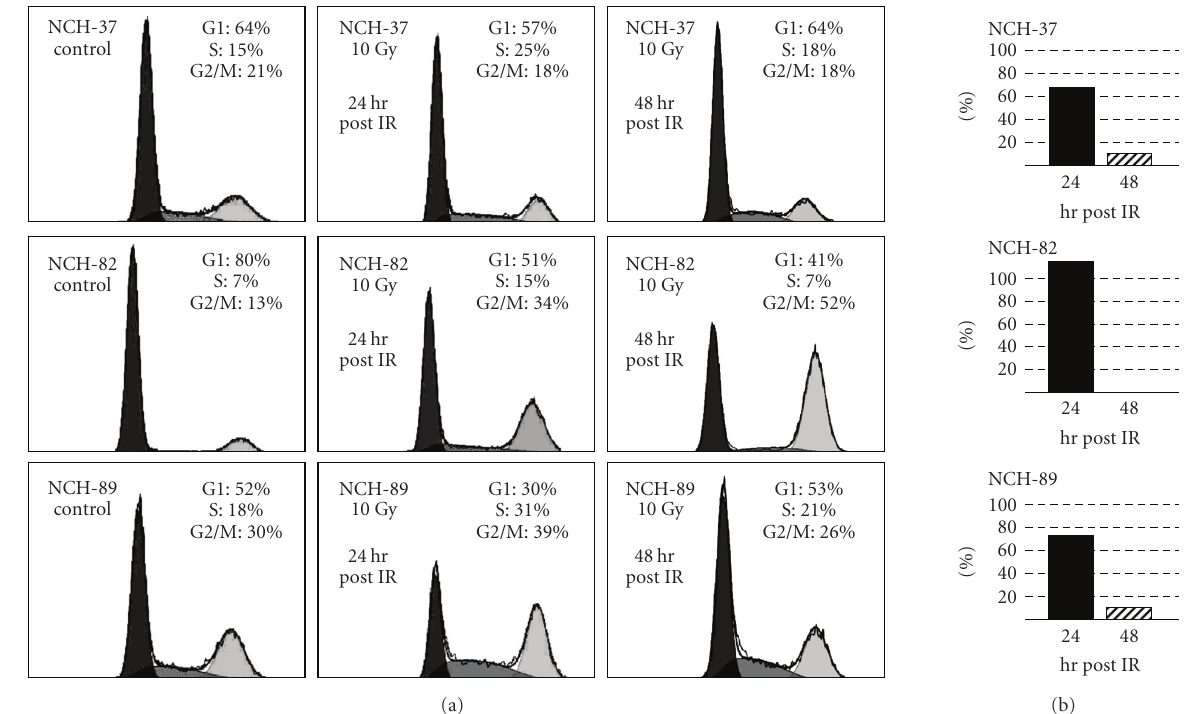
Figure 5: E ff ects of ionizing radiation (IR) on the cell cycle of human high-grade glioma cells. Short-term cultures of human gliosarcoma NCH- 37, human glioblastoma NCH-82, and human glioblastoma NCH-89 were irradiated with 10Gy, and cell cycle analyses were performed 24 hours post-IR (a, middle column ) or 48 hours post-IR (a , right column ). Control cells (a, left column ) were transported to the accelerator but not exposed to IR (ctrl.). (b) IR induced increase of S-Phase fraction in percent of unirradiated control cells. e ff ect of IR on the cell cycle of glioma cell lines (NCH-37, Table 1: Long-term e ff ect of ionizing radiation (IR) and/or parvovirus H-1 (H-1PV) infection on human high-grade glioma NCH-82, NCH-89). IR of glioma cell cultures with 10 cells cultures.